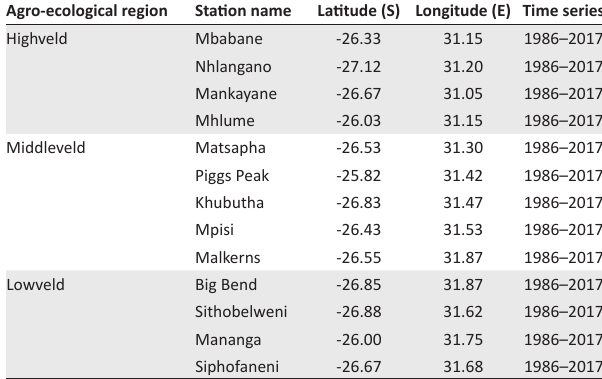
Legend plateauLowveldRainfall sta(cid:8)ons Highveld Middleveld Lobombo